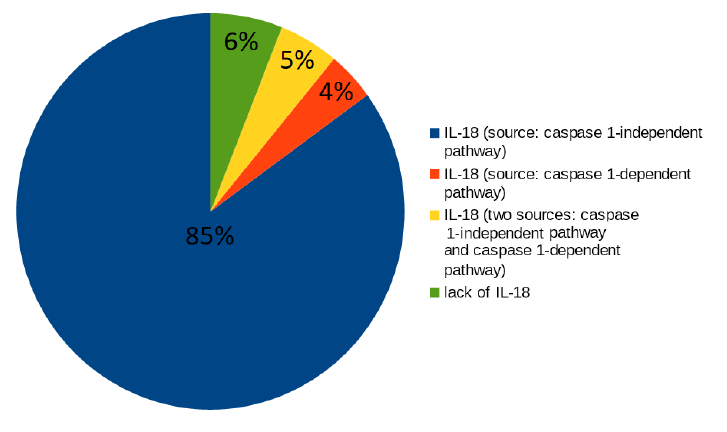
Figure 1. The diagram presents a count of t-invariants corresponding to subprocesses in which IL-18 produced by different pathways is engaged.